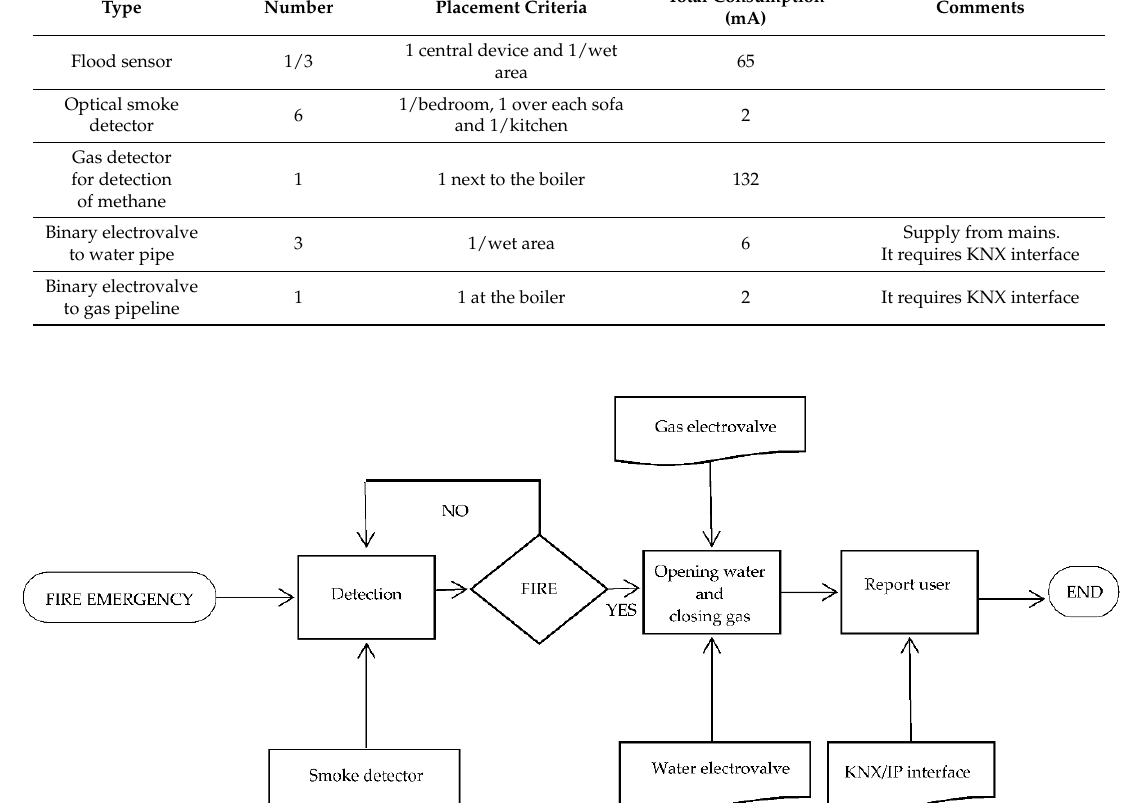
Table 9. Installed sensors and actuators in advanced home automation system Table 8. Elements of technical alarms subsystem in common with the other systems.